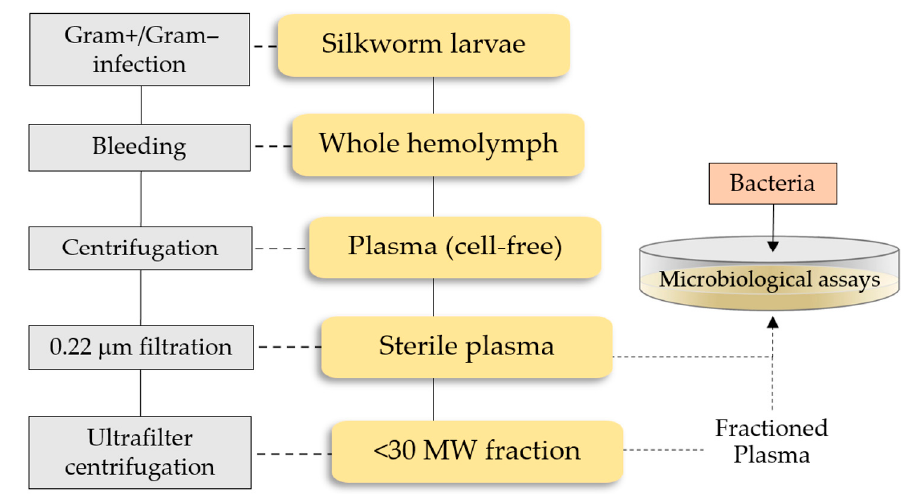
Figure 6. A schematic outline of the procedure to obtain the low molecular weight (MW) plasma fraction containing the silkworm AMPs pool.